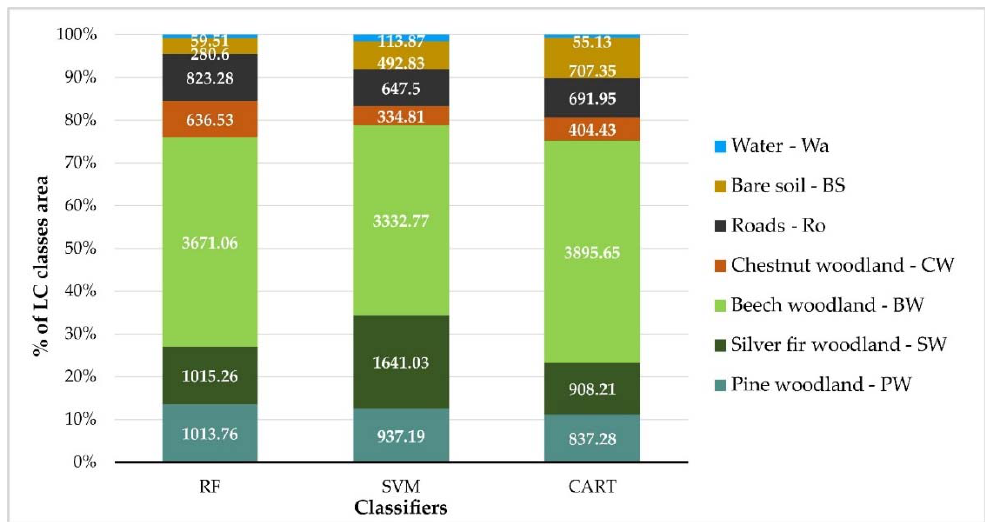
Figure 6. Percentages of total area occupied by each LU/LC class (Wa: water; BS: bare soil; Ro: roads; CW: chestnut woodland; BW: beech woodland; SW: silver fir woodland; PW: pine woodland) for each classifier: random forest (RF), support vector machine (SVM), and classification and regression tree (CART).